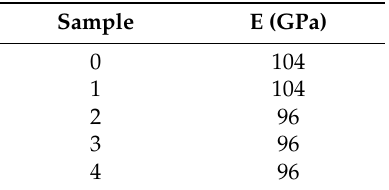
Table 7. Young’s modulus of the pristine copper samples.